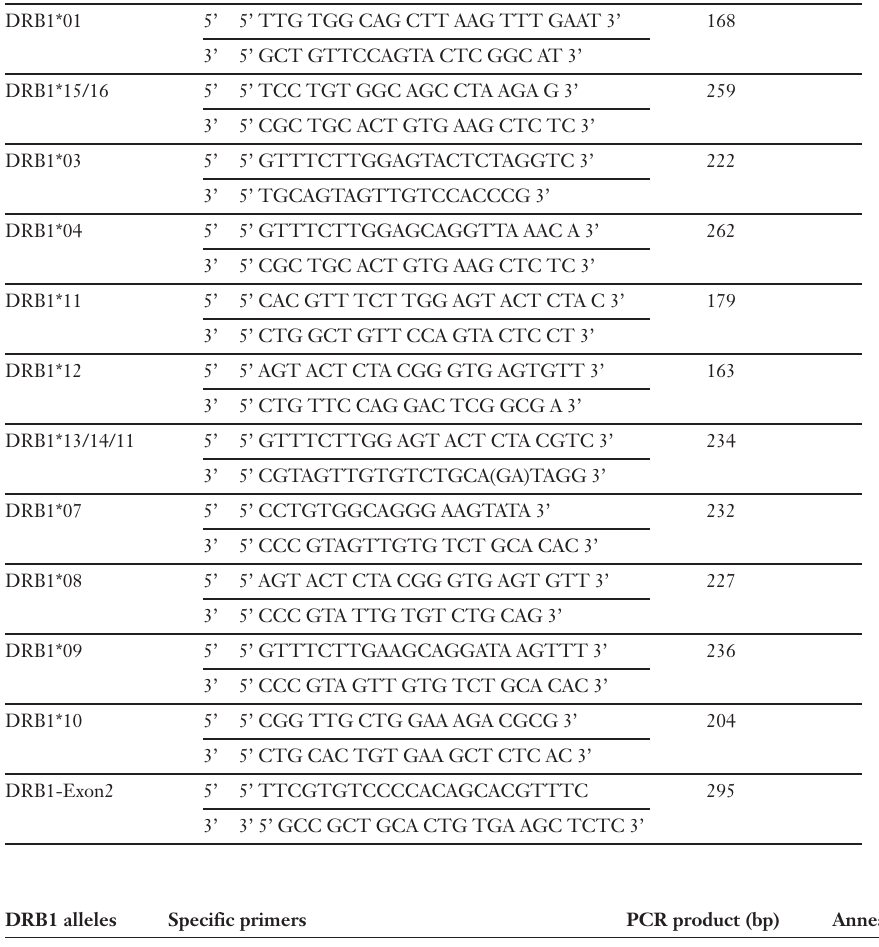
Table 2 Outline of HLA-DRB1 allele genotyping.